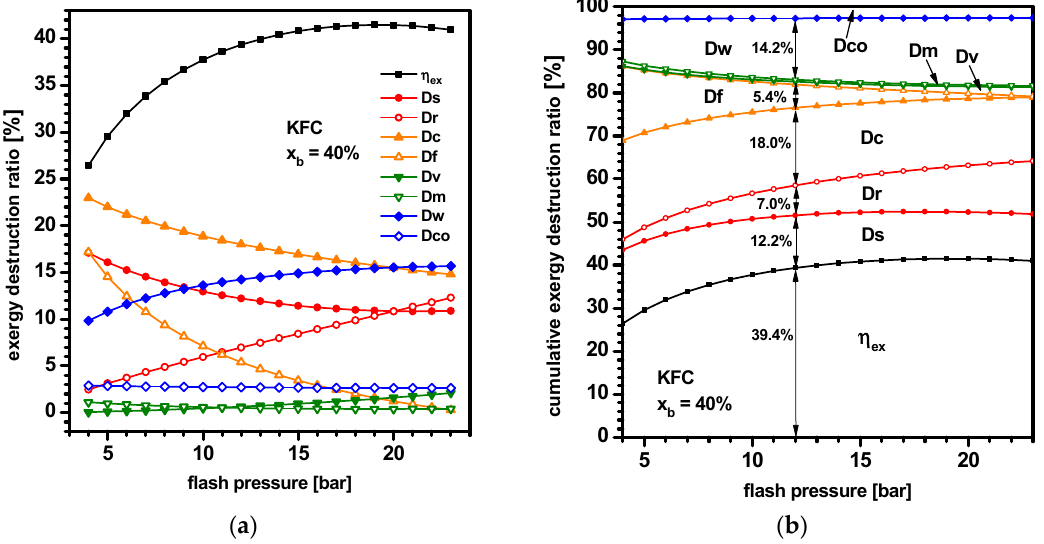
Figure 4. Dependence of ( a ) separate and ( b ) cumulative ratios of exergy consumption on the flash pressure for x b = 40%. Table 3. Example data of separate and cumulative ratios of exergy consumption for x b = 40% and P f = 12bar.